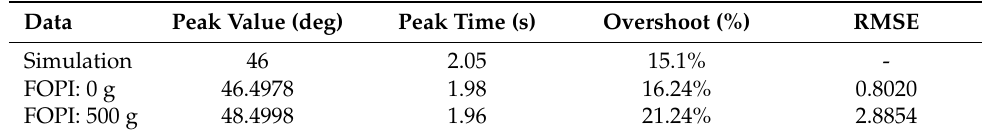
Table 6. FOPI system response. Control specifications: φ m = 60 ◦ and ω gc = 1.5